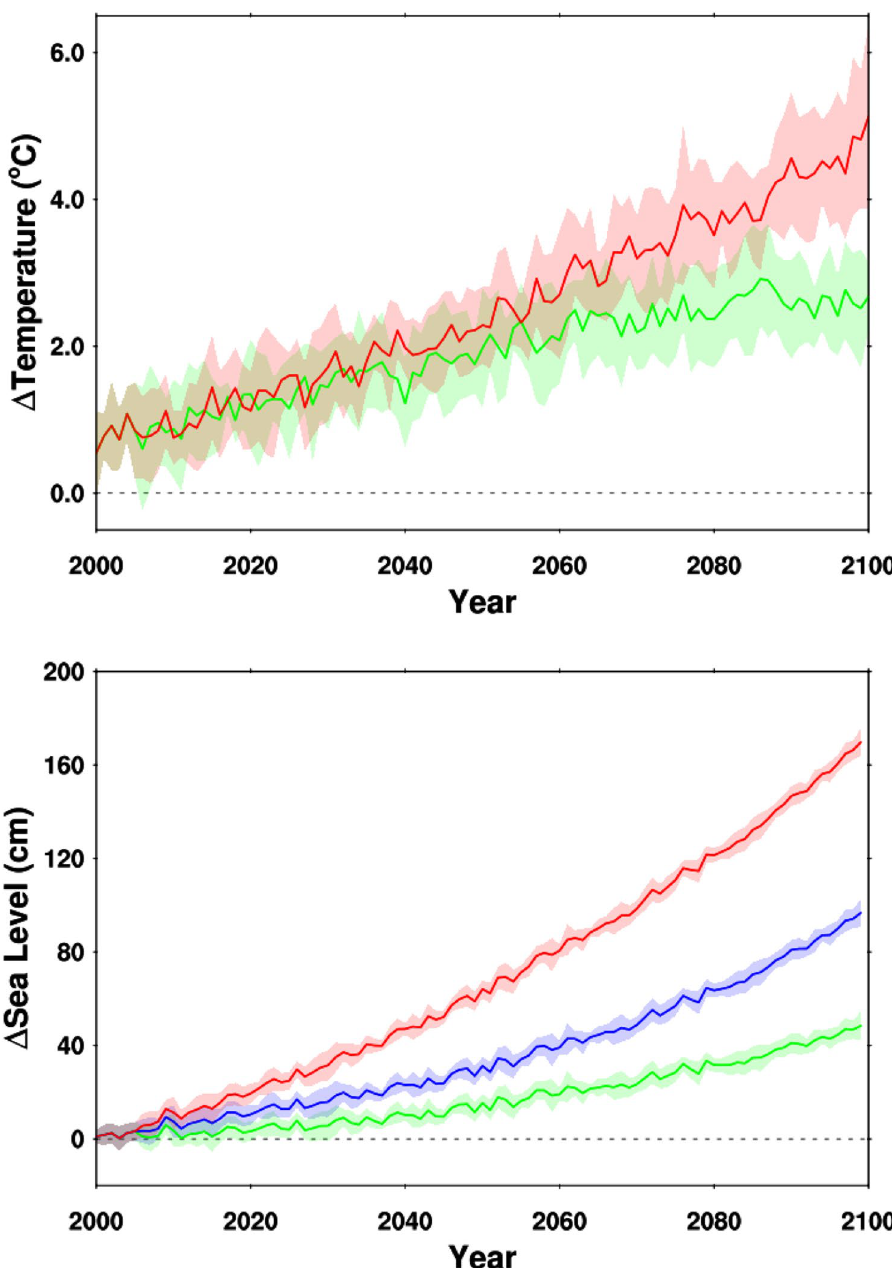
Figure 2. Global Climate Model projections of climate metrics for the Santa Barbara, California, region through 2100. Top panel: Annual mean temperature anomalies (relative to 1970–1999 base period) in the Goleta-Santa Barbara-Carpinteria coastal region from an ensemble of ten climate models employing the RCP 4.5 (green) and RCP 8.5 (red) emission scenarios. Solid line is the ensemble mean while the envelope is + /− one standard deviation of the individual model annual values from the ten model ensemble mean. Bottom panel: Departures of annual mean sea level (relative to year 2000 values) using three sea level rise scenarios and eight climate model projections using the RCP 8.5 emission scenario. The sea level rise scenarios are the low-range (green), mid-range (blue), and high-range (red) estimates from the National Research Council (NRC) 2012 report 85 . The solid line represents the ensemble mean while the envelope is + /− one standard deviation of the annual values from the eight models about the ensemble